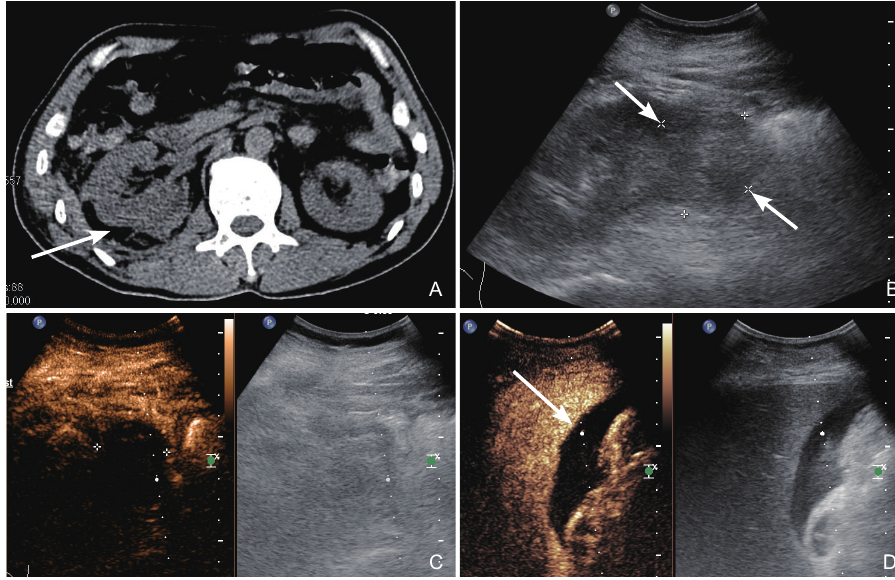
Figure 11 Kidney injury in a 23-year-old female patient involved in a traffic accident. (A) CT scan showed a low-density mass without a clear boundary in the lower pole of the right kidney (arrow); (B) Gray-scale ultrasound image at the same region in figure A showed a complex mass (white arrows); (C) CEUS imaging showed the lesion without enhancement (perfusion defect denoted by marks, 2.5 × 1.8 × 2.5 cm). No active bleeding was identified during the CEUS exam; (D) An unenhanced fluid collection (white arrows) was seen under the left lobe of the